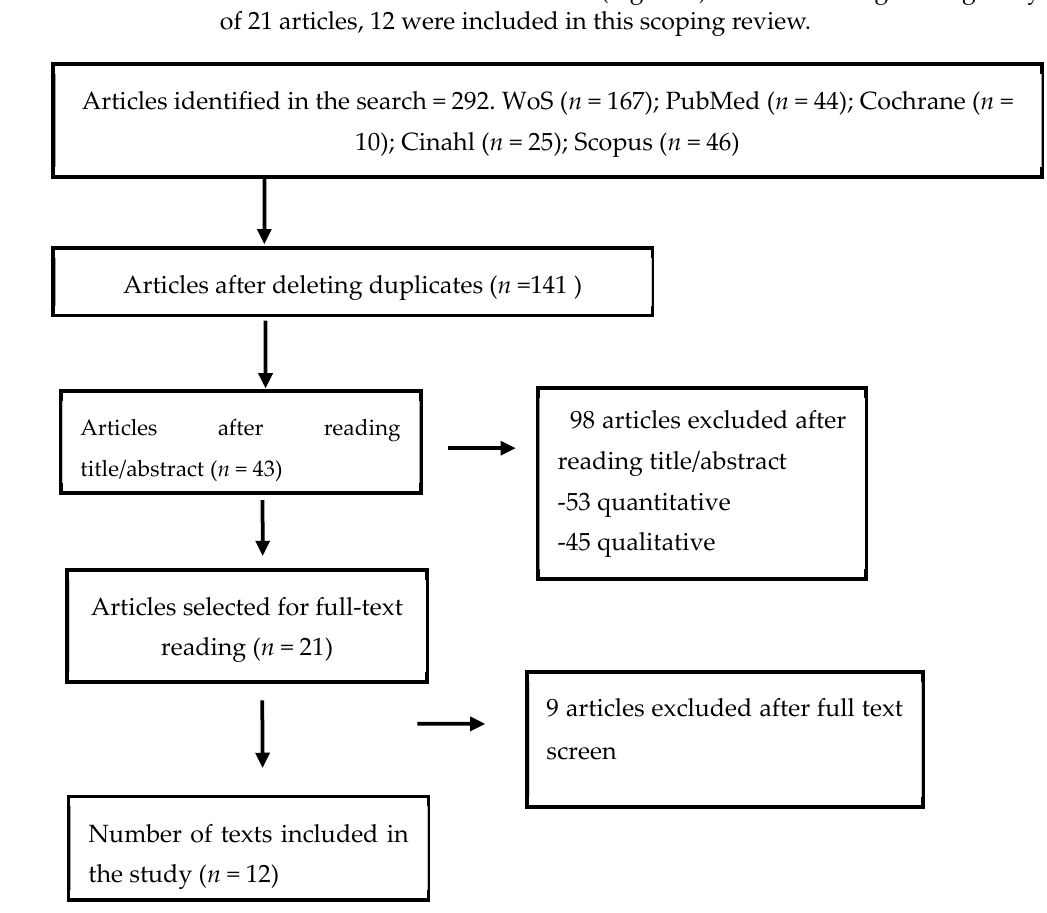
Figure 1. PRISMA flow diagram for study selection.